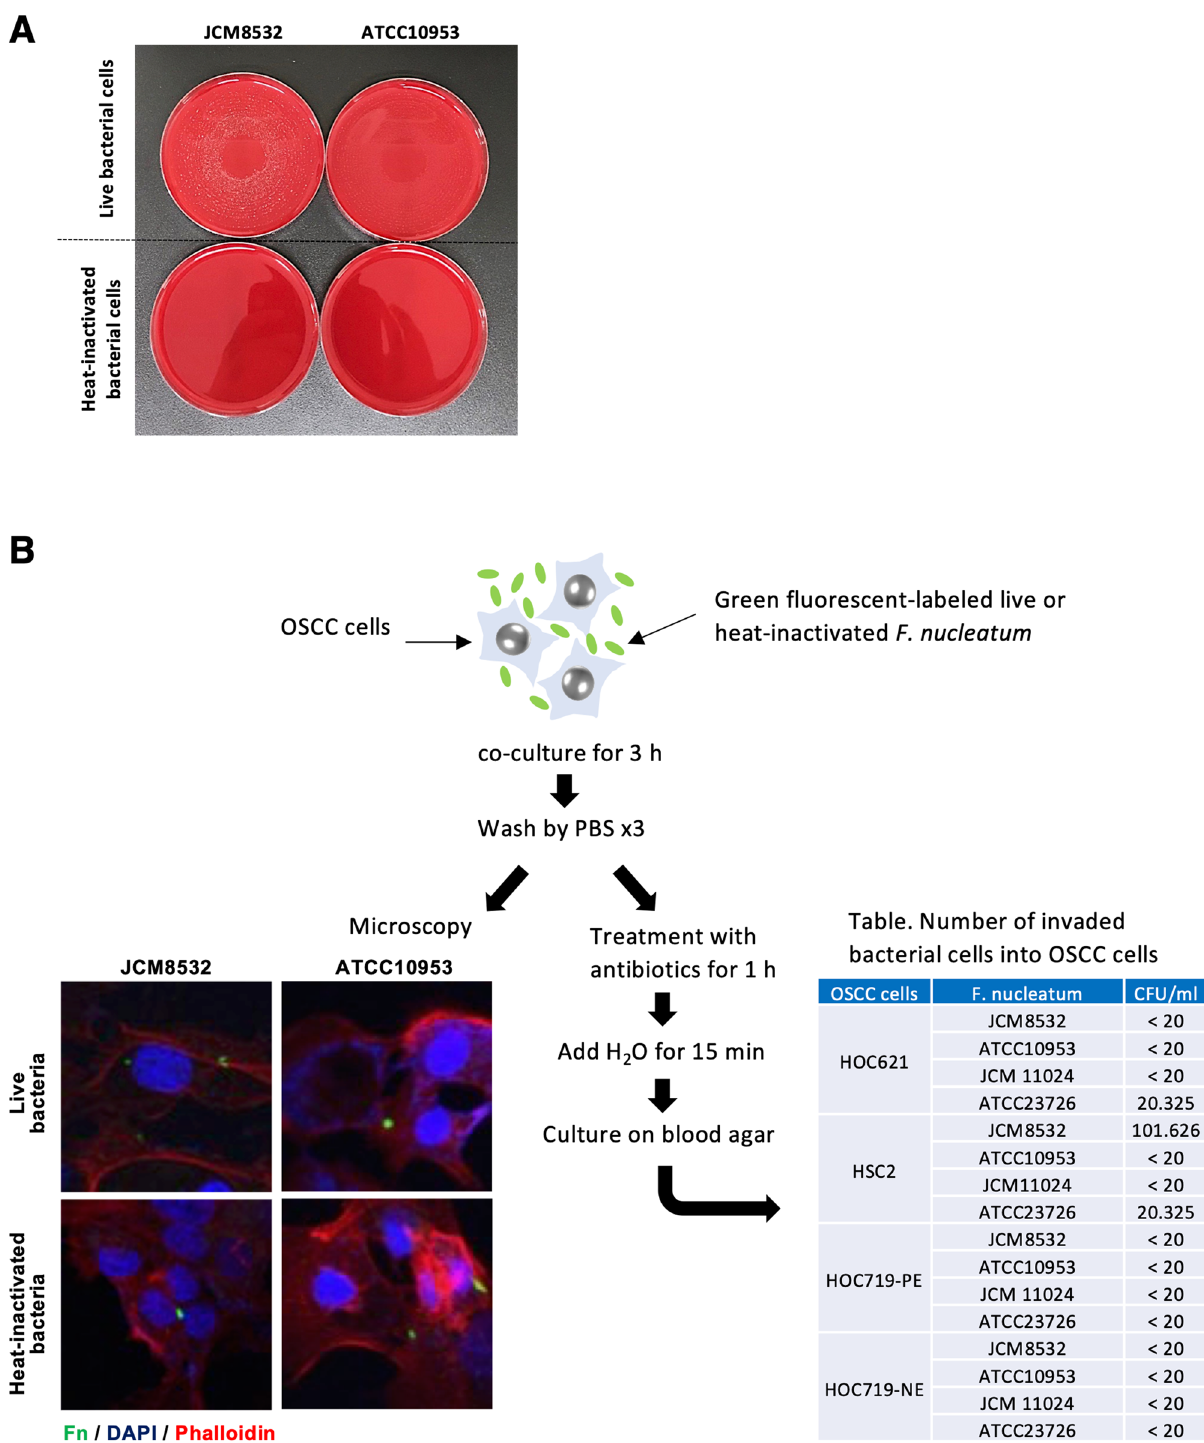
Figure 2. Preparation of heat-inactivated F. nucleatum and attachment of F. nucleatum on the surface of OSCC cells. ( A ) Pictures of F. nucleatum colonies. The heat-inactivated F. nucleatum bacterial cells were prepared by heating for 15 min at 100 °C. Bacterial cells show no colony forming on sheep blood agar after heat inactivation. ( B ) Attachment of F. nucleatum on the surface of OSCC cells. Green fluorescent-labeled live or heat-inactivated F. nucleatum (JCM8532 and ATCC10953) were co-culture with OSCC cells for 3 h. After washing by PBS, attached cells on the surface of OSCC cells were checked by immunofluorescence microscopy. Images show that heat-inactivated or live bacterial cells attach on the surface of OSCC cells. Moreover, invaded bacterial cells into OSCC cells were examined by culture on blood agar after treatment with antibiotics. Table shows the number of invaded F. nucleatum (CFU/ml) in OSCC cells (HOC621, HSC2, HOC719-PE, and